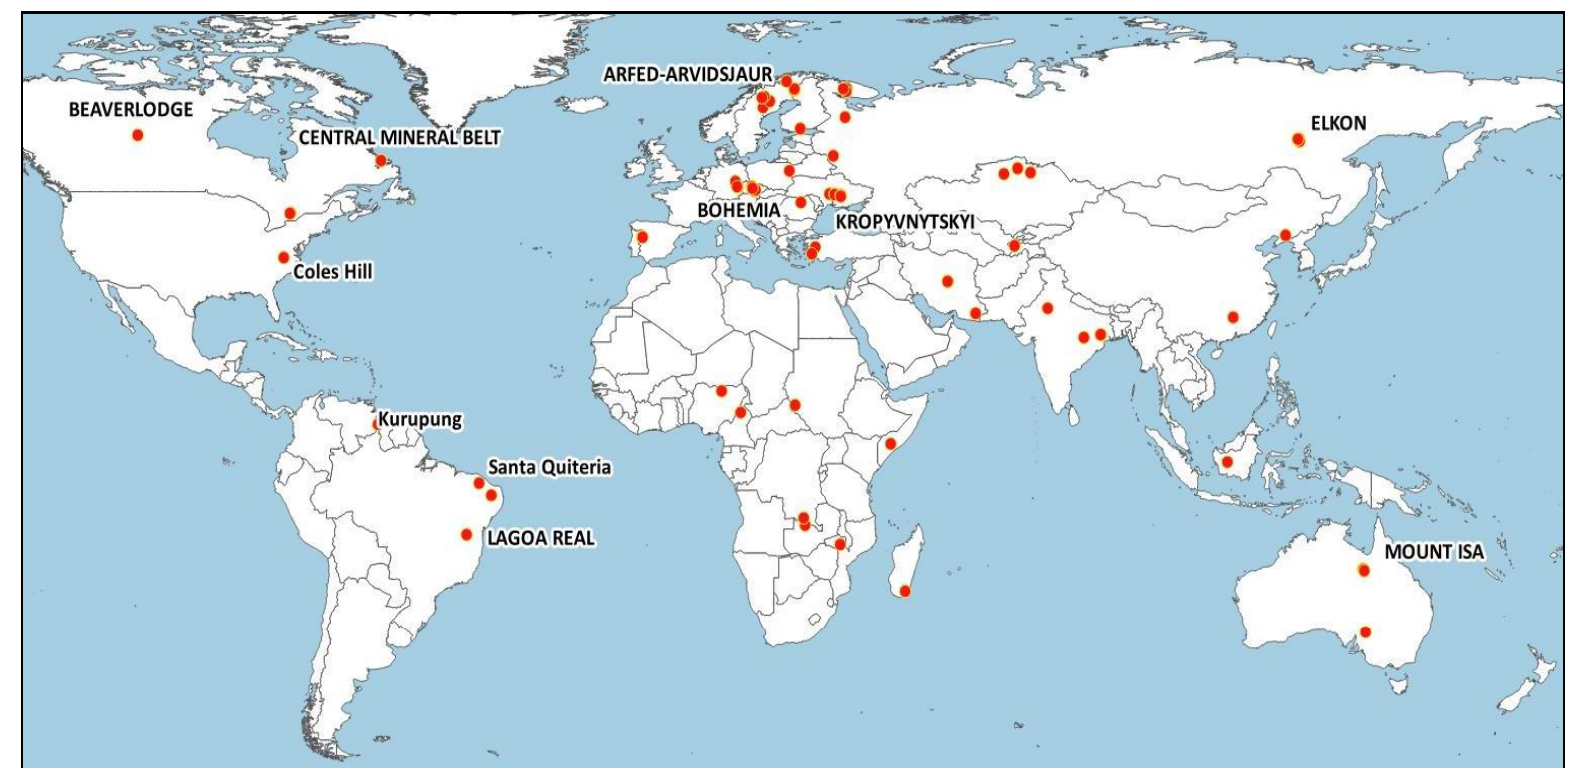
Figure 1. Location of major shear-zone hosted U deposits and districts. District names are